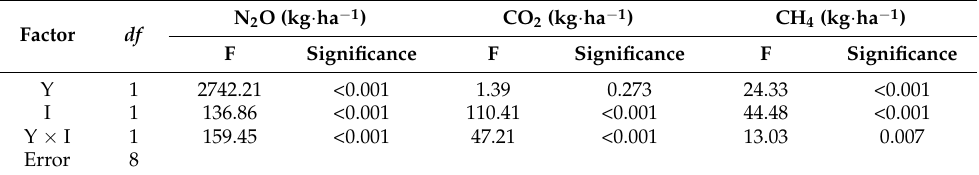
Table 3. Significance, values, and degrees of freedom for two-way